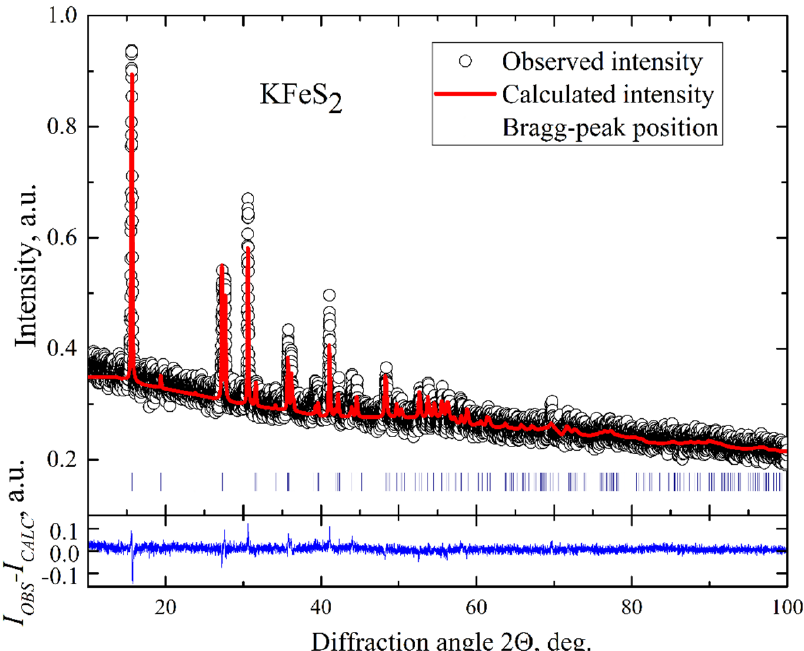
Figure 2. Powder X-ray diffraction pattern of KFeS 2 . The empty circles represent the measured intensities. The solid red line is the refined pattern. The Bragg peak positions are indicated by vertical blue bars. The blue line represents the difference between the measured spectrum and the fit.